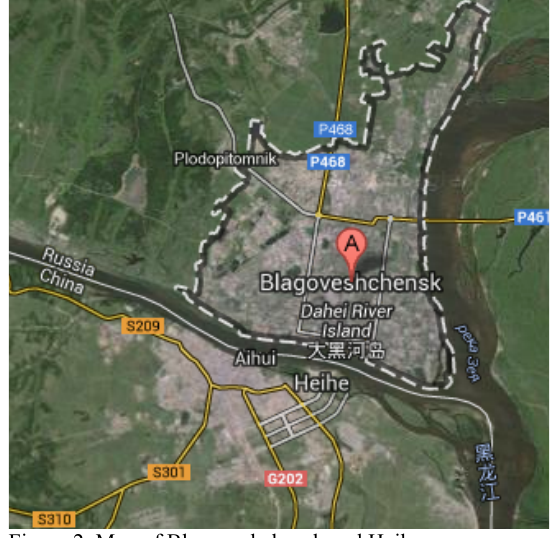
Figure 2. Map of Blagoveshchensk and Heihe As it was stated in interview B, the Russian-Chinese cross- border cooperation could be better understood if one pays attention to a contradiction between inertness from the Russian side of the border and an abundance of initiatives coming from the Chinese